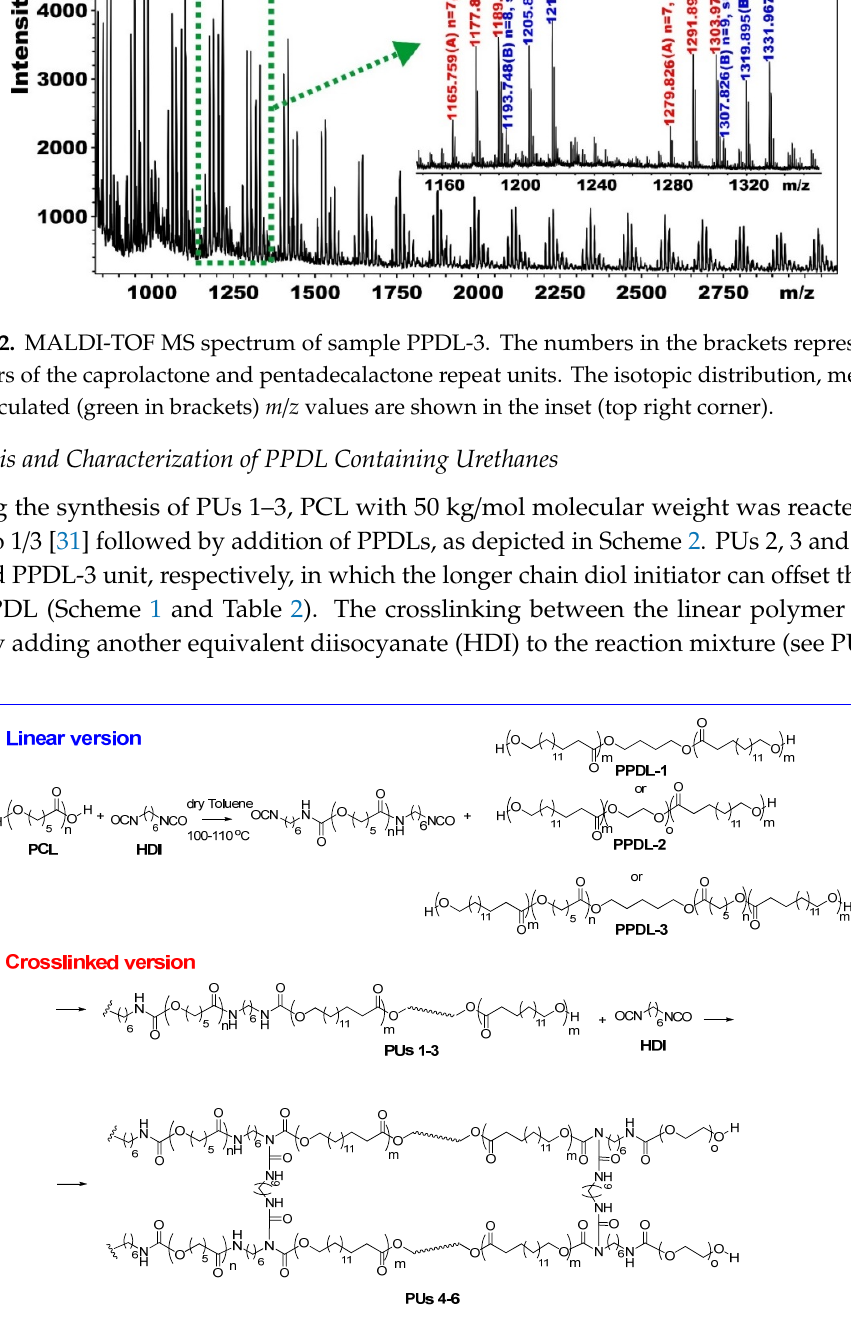
Figure 2. MALDI-TOF MS spectrum of sample PPDL-3. The numbers in the brackets represent the numbers of the caprolactone and pentadecalactone repeat units. The isotopic distribution, measured and calculated (green in brackets) m / z values are shown in the inset (top right